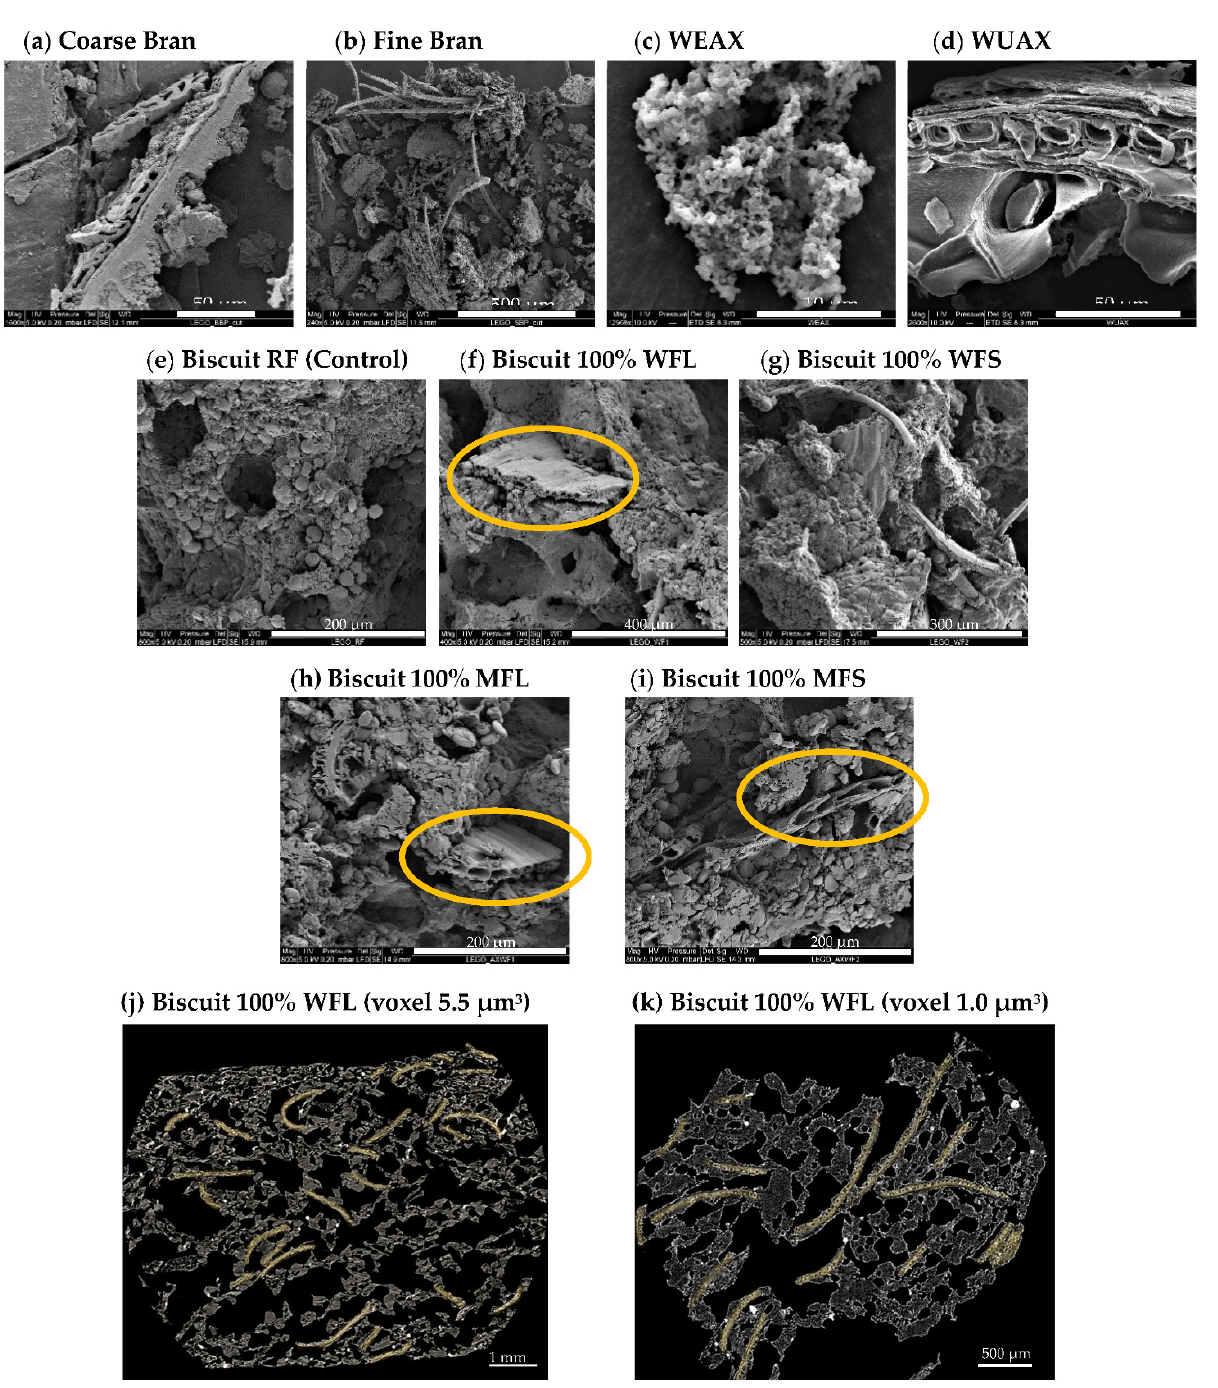
Figure 5. Scanning electron microphotographs (at magnifications between 240 × and 12,968 × ) of the following fibres: coarse bran ( a ), fine bran ( b ), water-extractable arabinoxylan ( c ), and water-unextractable arabinoxylan ( d ), where the porous structure of the fibre is circled in yellow. Also, cross-sectional scanning electron microphotographs (at magnifications between 400 × and 800 × ) of biscuits prepared with refined flour (RF) ( e ), whole flour with coarse bran (WFL) ( f ), whole flour with fine bran (WFS) ( g ), and model flours with an equivalent arabinoxylans content to that found in flours with 100% whole flour replacement (MFL or MFS) ( h , i ). Images ( j , k ) are cross-sectional images (z plane) obtained by X-ray μ CT of a biscuit prepared with 100% whole flour with coarse bran (WFL), which is highlighted in light yellow.